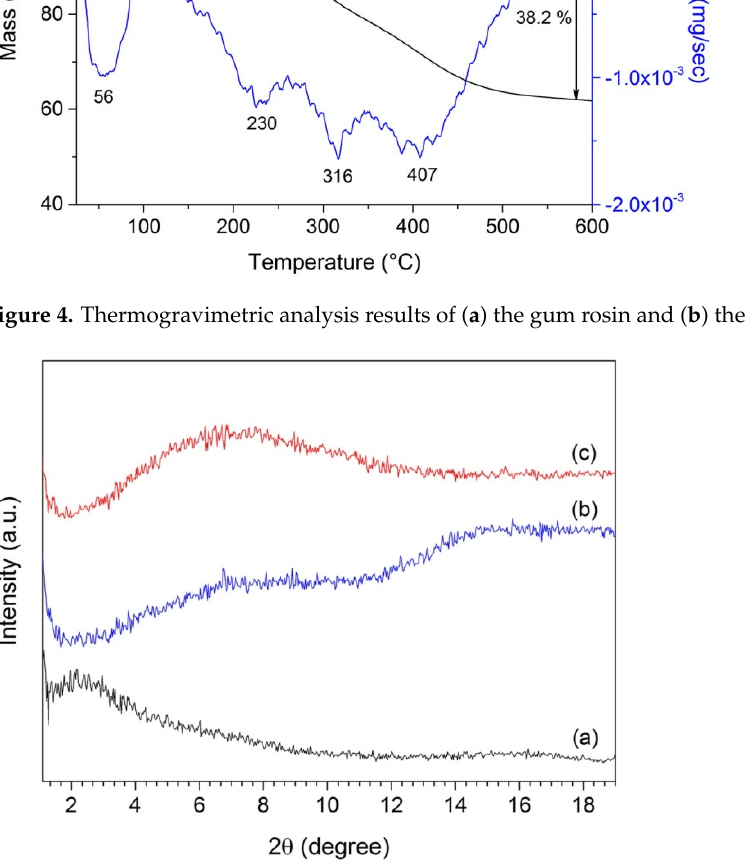
Figure 5. XRD patterns of ( a ) the synthesized OMMT, ( b ) the mixture of rubbers and ( c ) the OMMT- modified rubber.